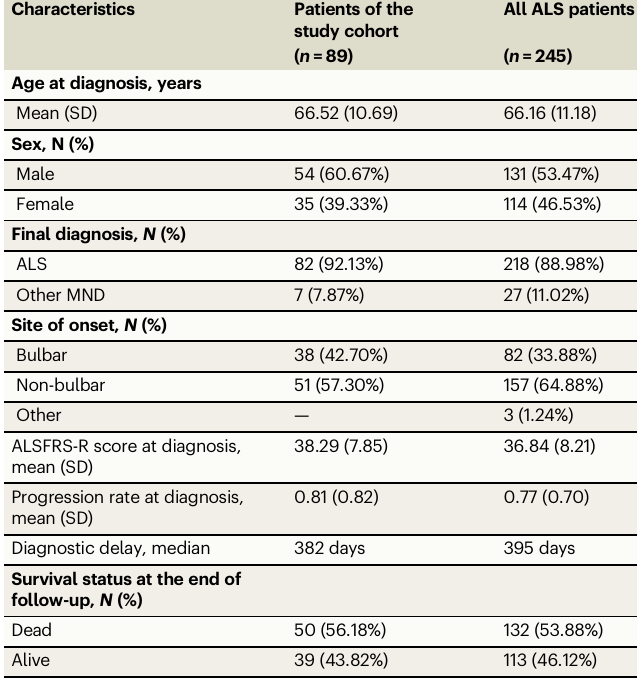
Table 1 | Characteristics of the study cohort and the entire population of ALS patients diagnosed during the study period in Stockholm, according to the Swedish Motor Neuron Dis- ease Quality Registry